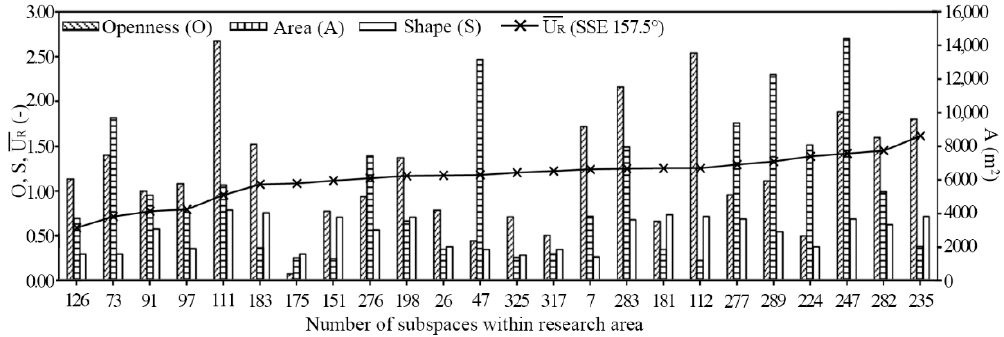
Figure 12. U (cid:2902) (cid:3364)(cid:3364)(cid:3364)(cid:3364) of the SSE 157.5° wind direction and the spatial characteristics’ indices of 24 Figure 12. U R of the SSE 157.5 ◦ wind direction and the spatial characteristics’ indices of 24 subspaces. subspaces.